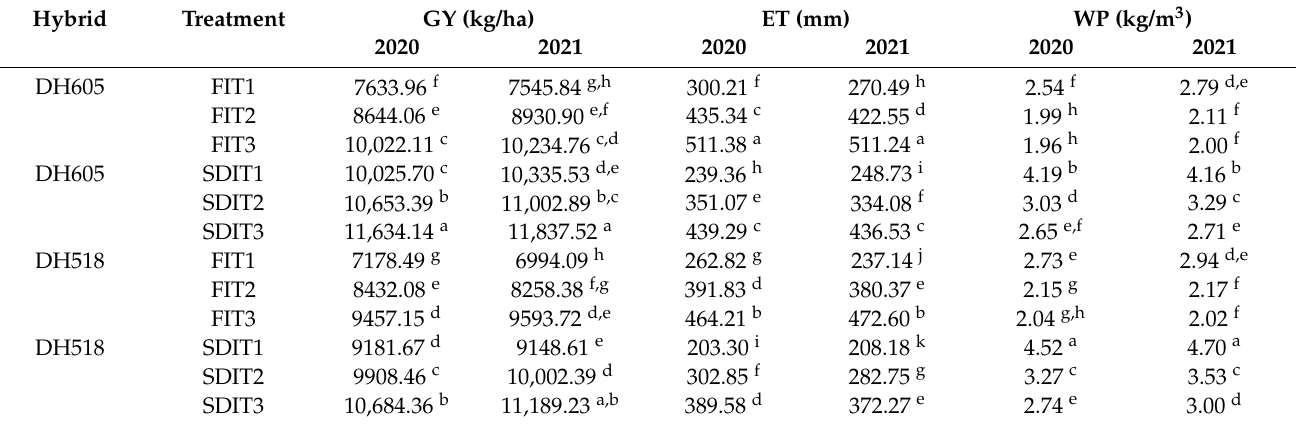
Table 4. Effects of different irrigation treatments on GY, ET and WP of two corn hybrids differing in